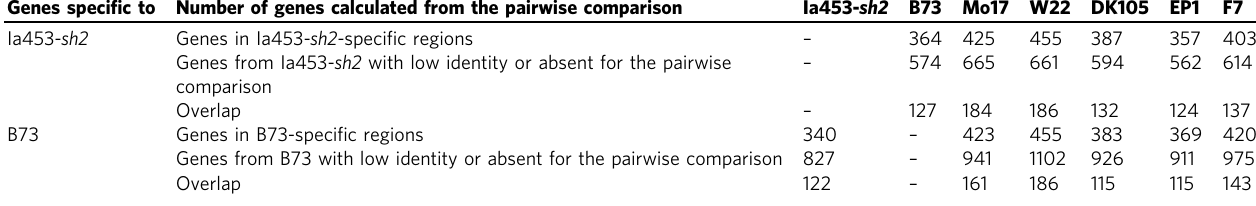
Table 2 Summary of the Ia453- sh2 - and B73-speci fi c genes compared to other six corn genomes. Genes speci fi c to Number of genes calculated from the pairwise